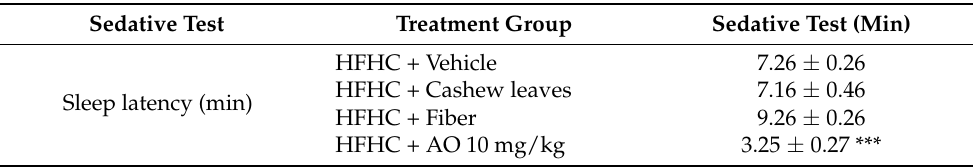
Table 8. Effects of the leaf extract, fruit pomace-derived dietary fiber, and the functional ingredient from A. occidentale on sedative and hypnotic